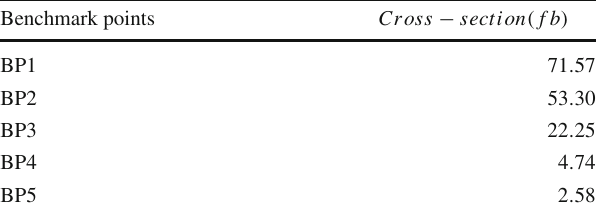
Table 5 The LO cross-sections for the signal pp → 1 (cid:3) + E T / Benchmark